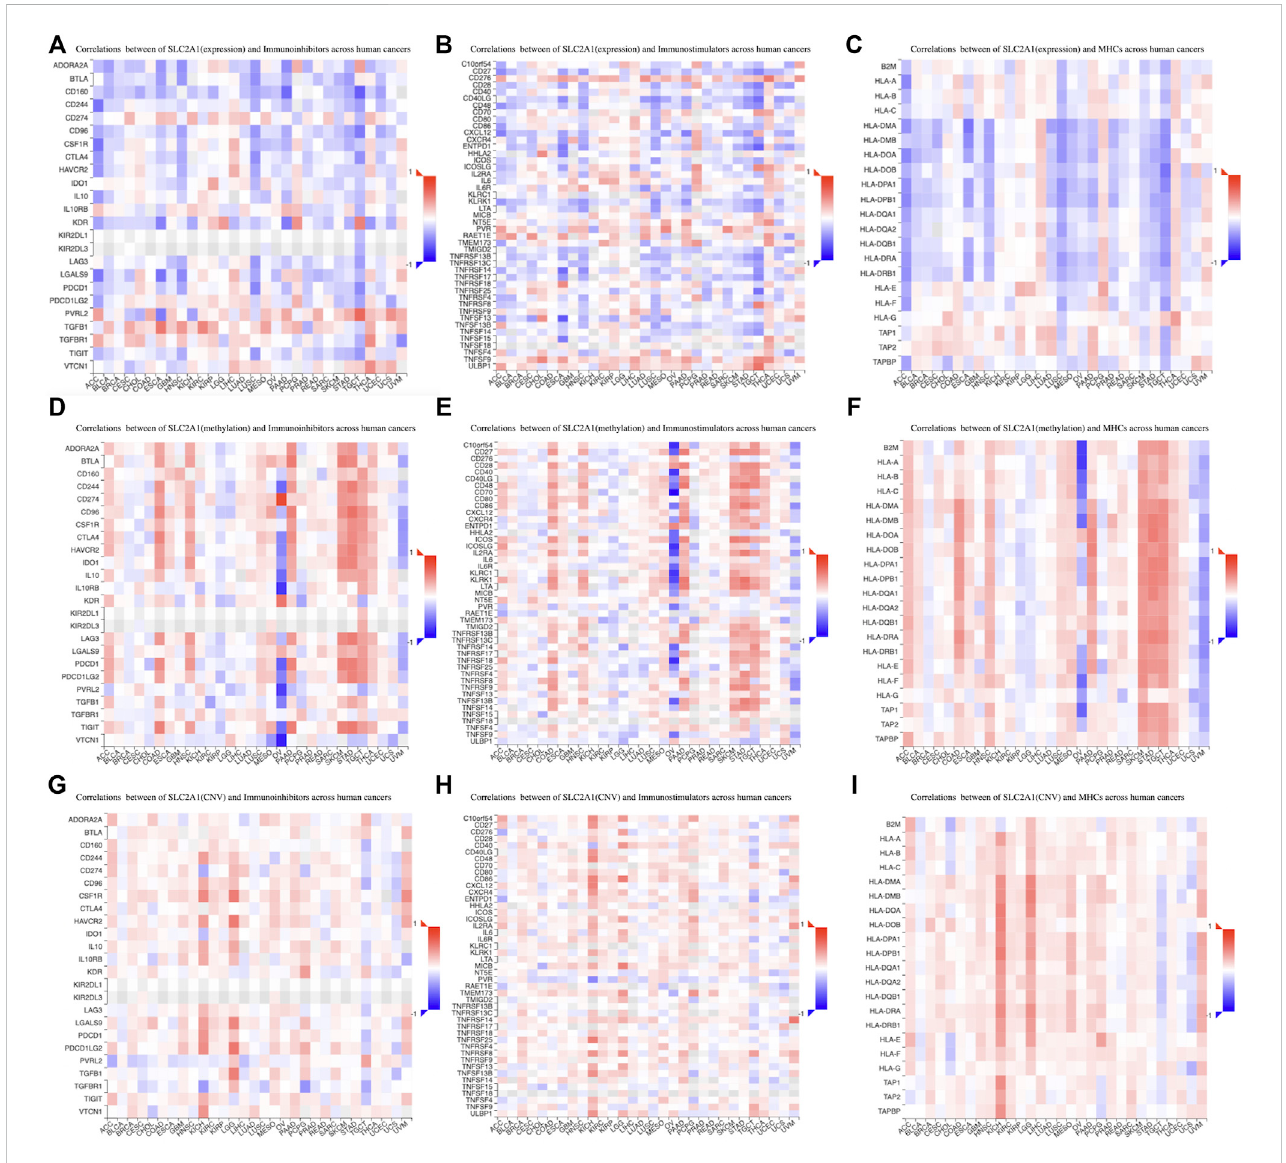
FIGURE 11 The association between SLC2A1 expression and (A) immunoinhibitors genes (B) immunostimulators genes, and (C) MHC genes in pan-cancer accordingtoTISIDBdatabase.TheassociationbetweenSLC2A1methylationleveland (D) immunoinhibitorsgenes (E) immunostimulatorsgenes,and (F) MHC genes in pan-cancer. The association between copy number variant level of SLC2A1 and (G) immunoinhibitors genes (H) immunostimulators genes, and (I) MHC genes in pan-cancer. Red indicated a positive correlation and blue indicated a negative